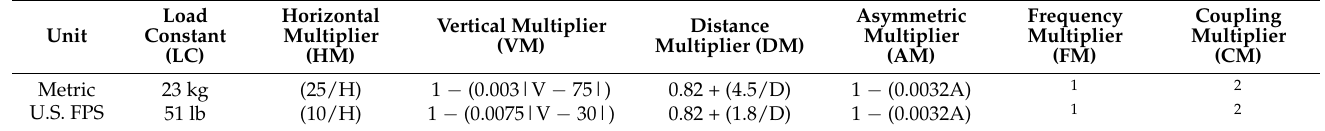
Table 1. NIOSH Lifting Equation Multipliers.